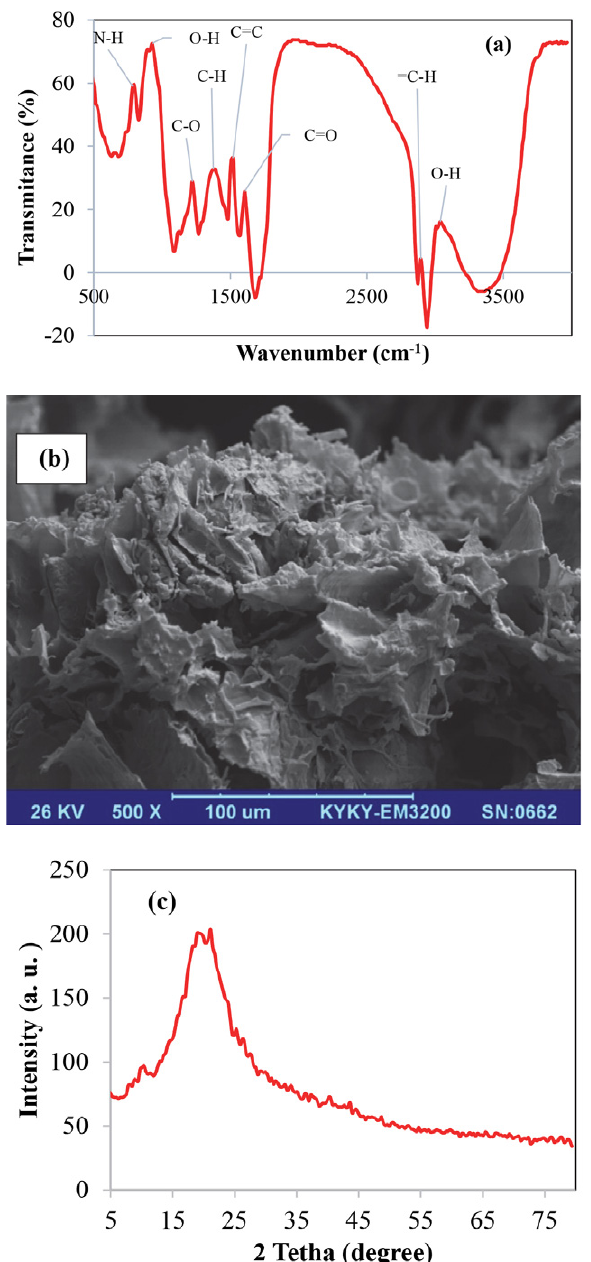
Figure 2. The characteristics of the activated carbon made from Mo- ringa oleifera plant using various analyses, including FTIR (a), SEM (b), and XRD